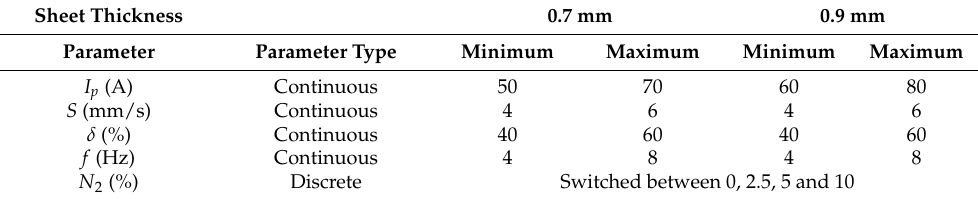
Table 2. Parameter ranges used for homogeneous welds made on 0.7 mm and 0.9 mm thick sheets. Sheet